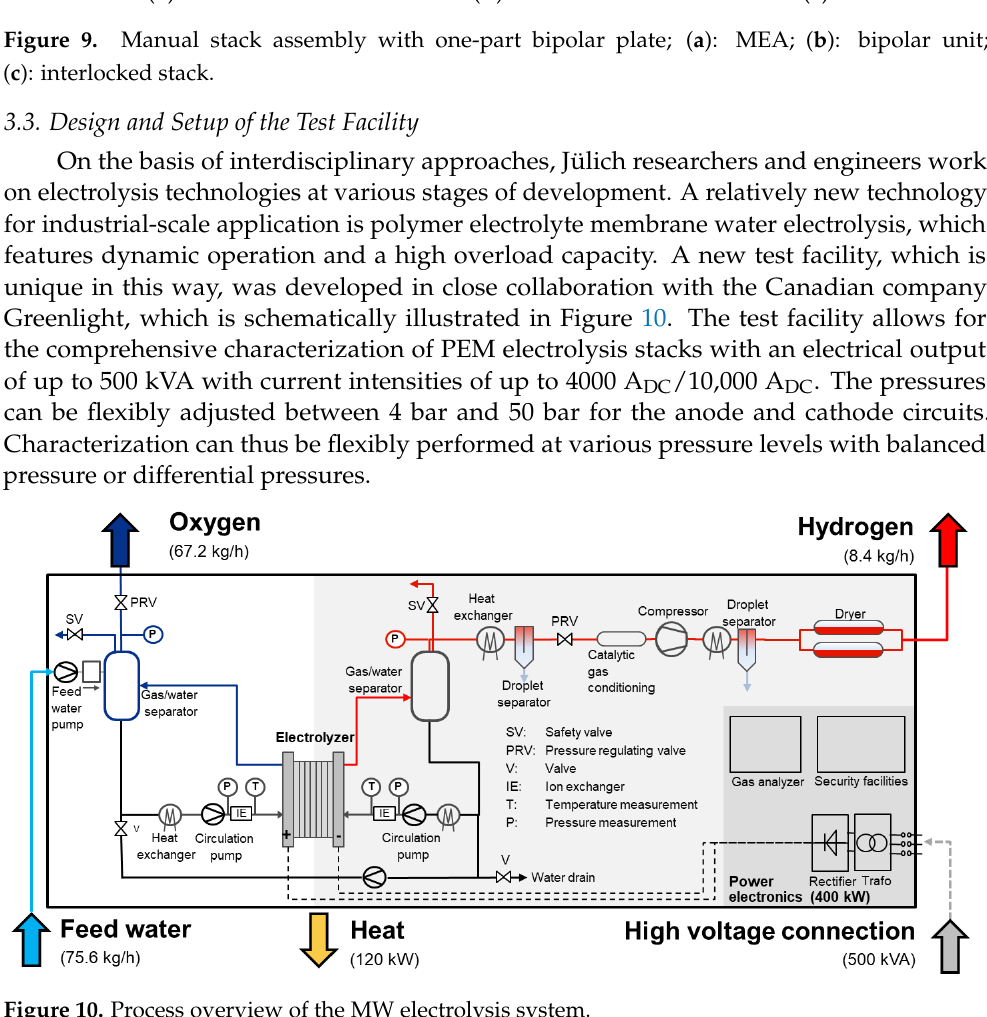
Figure 10. Process overview of the MW electrolysis system.